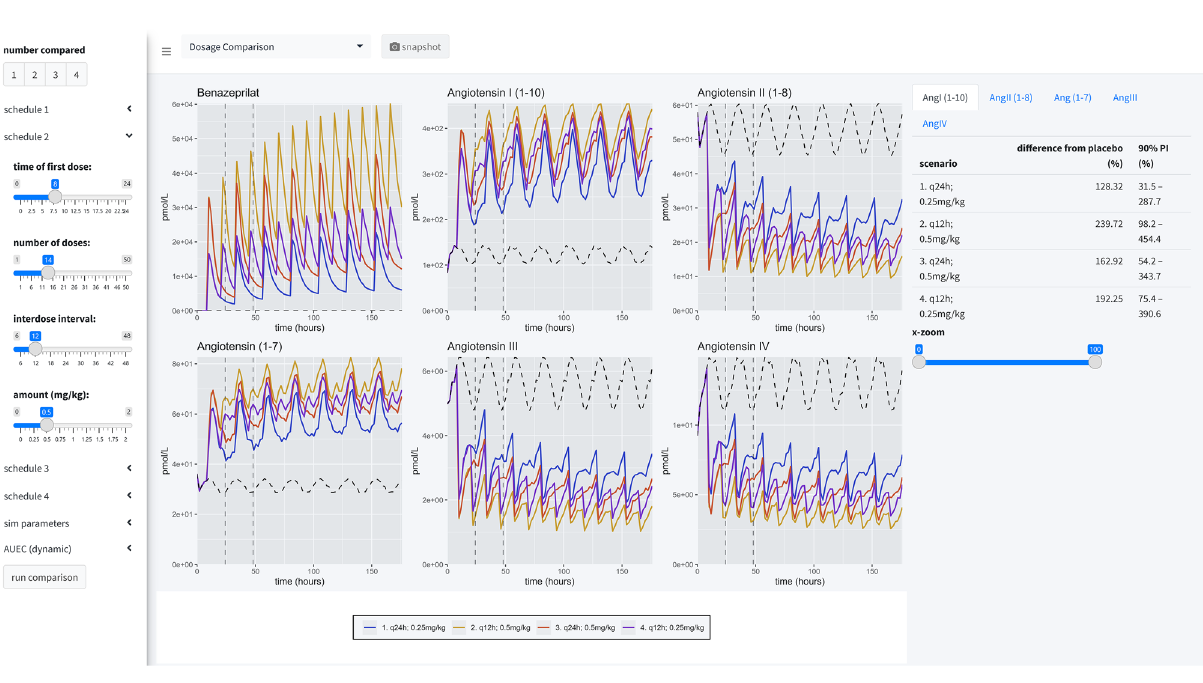
Figure 7. Application views. Our application provides a user-friendly way to apply our model of RAAS response to various administration schedules of benazepril. A collapsible left-hand widget allows the user to specify the simulation. The application has 3 separate panels. In the first panel, a single dosage scheme can be applied to a large simulated population of animals. Then the prediction distribution of simulated patient responses is plotted for study. In the second panel, the user can make a comparison between several proposed administration schedules. The plots produced in this panel depict the median time-course of the various metabolites in response to the proposed schedules. The user also has access to an x-axis zoom and AUC comparison summaries on the right-hand side. The final panel is simply documentation of the simulation engine code and tips for